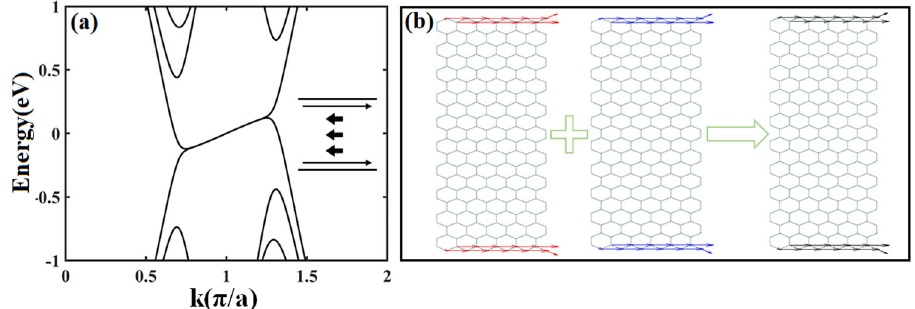
Fig. 2 The band structure and local bond current distribution for pristine antichiral edge states. a The band structure. Inset: schematic diagram of corresponding edge states. b The local bond current distribution ( E = 0.03 eV) for the pristine antichiral edge states. The black bands (arrows) denote the spin degeneracy case, and the red (blue) arrows indicate the spin-up (down) case. The other fi xed parameters are: N y = 40, W = 8, λ MHM ¼ 0 : 058 t (relevant parameter of the modi fi ed Haldane